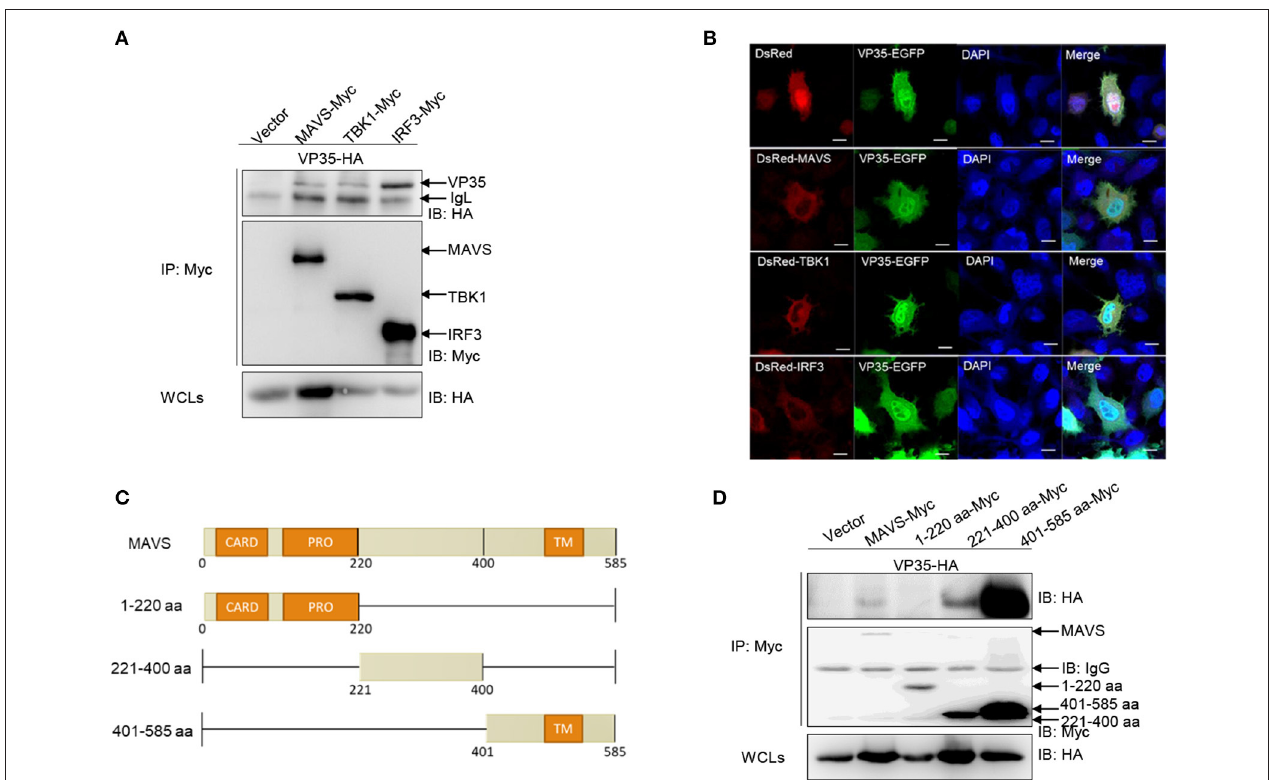
FIGURE 3 | VP35 is distributed throughout the cells and interacts with (RIG-I)-like receptor (RLR) molecules. (A) Inoculated human embryonic kidney (HEK) 293T cells into 10-cm 2 dishes and transfected with the indicated plasmids (5 µ g each). After 24h, the cells were lysed and immunoprecipitated (IP) with Anti-Flag Affinity Gel. Then the immunoprecipitate and whole-cell lysates (WCLs) were analyzed by immunoblotting (IB) with anti-Flag and anti-Myc antibodies (Abs), respectively. (B) EPC cells were seeded into a six-well plate, and transfected with 1 µ g MAVS-DsRed, TBK1-DsRed, and IRF3-DsRed and 1 µ g VP35-EGFP or empty vector. After 24h, the cells were fixed and analyzed by confocal microscopy. The green signal indicates the over-expressed VP35 protein, the red signal indicates the over-expressed MAVS, TBK1, and IRF3, and the blue indicates the nuclear area (original magnification 63 × ; oil immersion objective). Scale bar, 10 µ m. (C) Schematic representation of full-length MAVS and its mutants. (D) The 221–400 aa and 401–585 aa of MAVS are responsible for its interaction with VP35. The experiments were performed similarly as described above for (A) . All experiments were repeated at least three times with similar